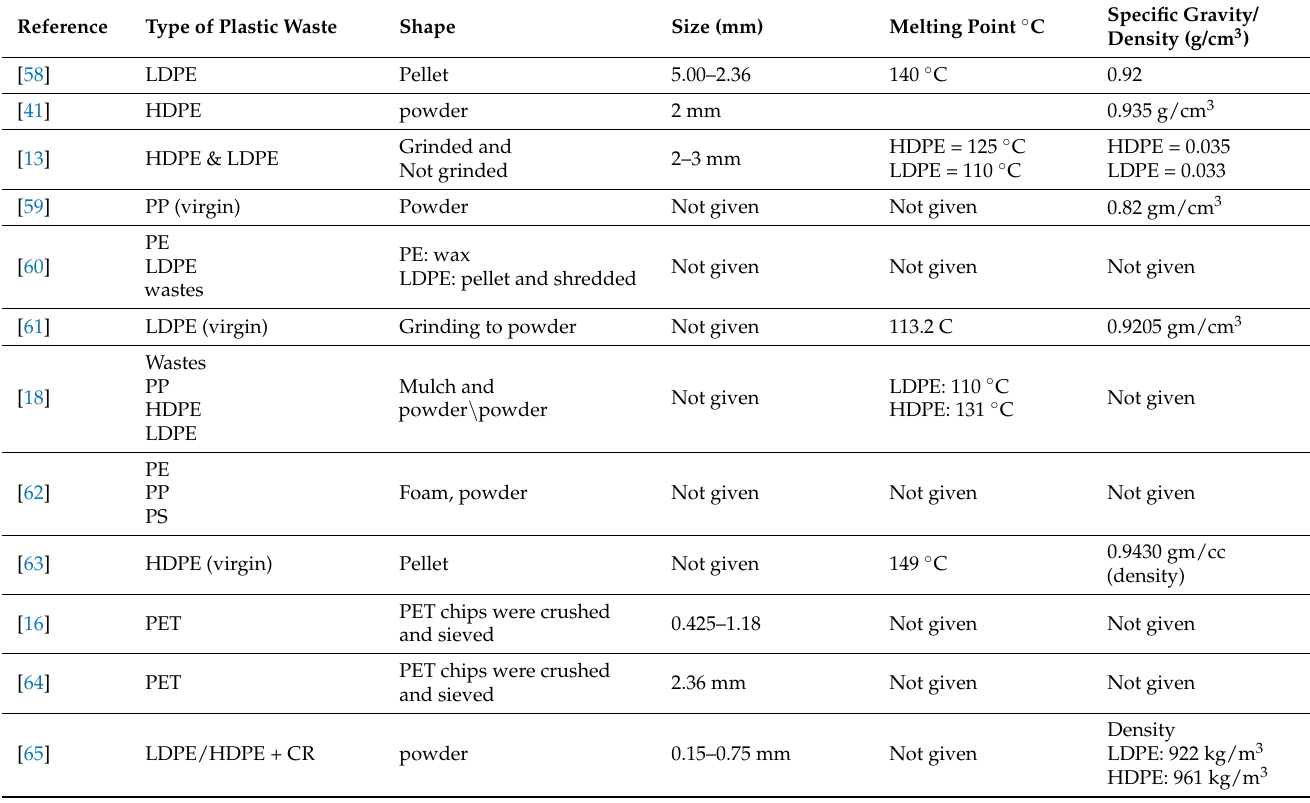
Table 2. Types of plastic used in previous research